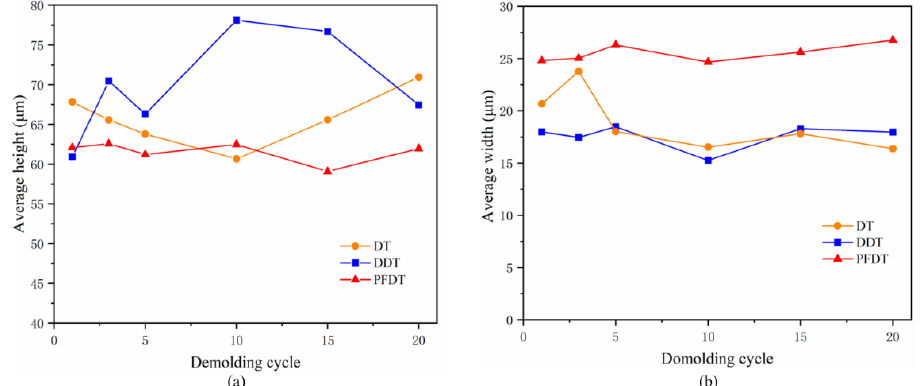
Figure 13. The ( a ) average height and ( b ) average width with demolding cycles.